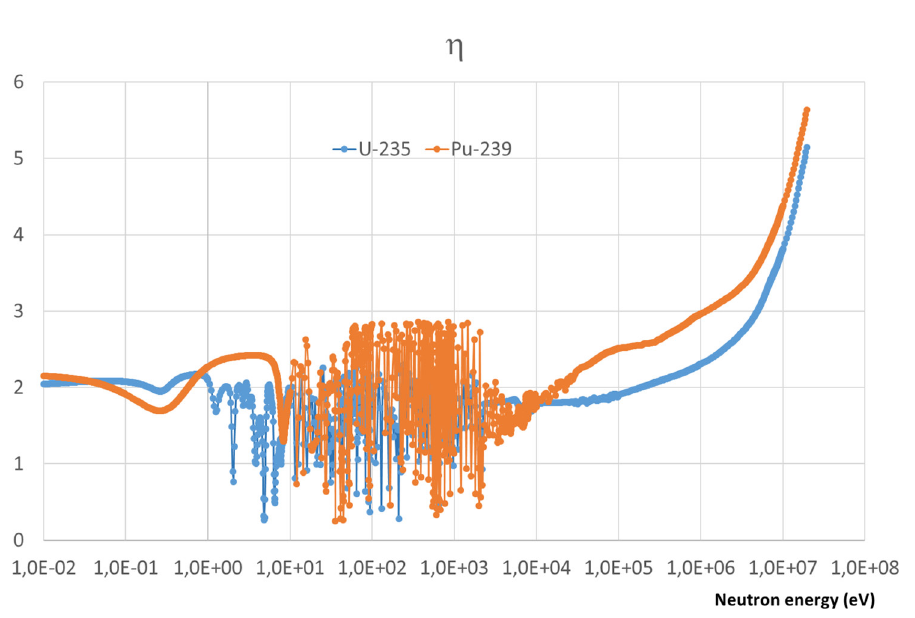
Fig. 4. – The parameter η as a function of neutron kinetic energy for the two main fissile nuclei.